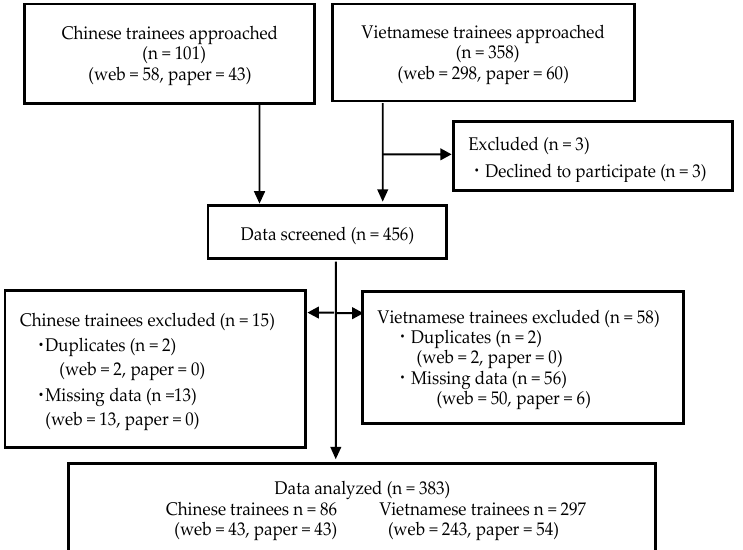
Figure 1. Flow diagram of study participants.